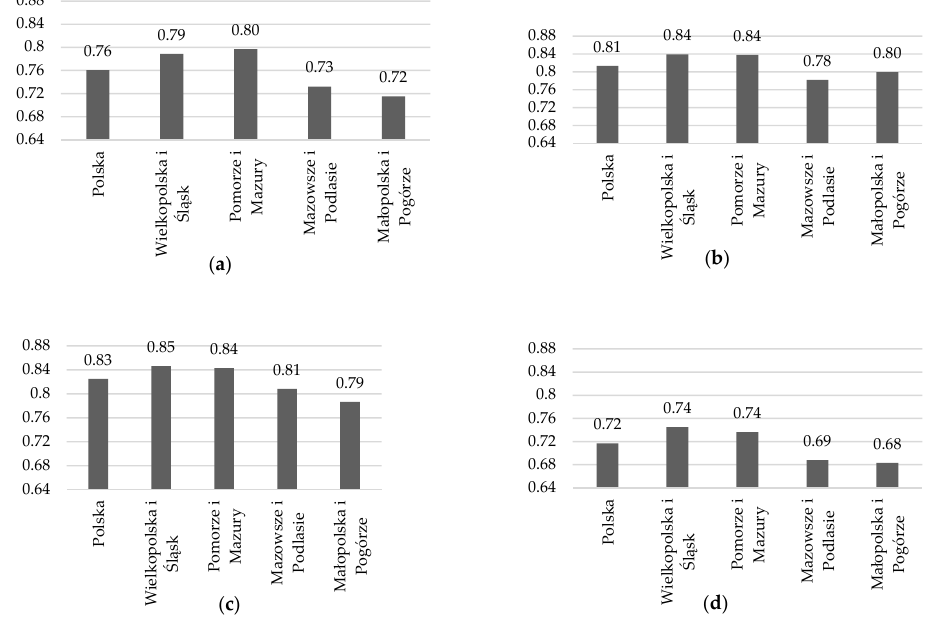
Figure 4. Average technical efficiency of farms in individual regions of Poland depending on the overinvestment group in 2004–2015. ( a ) optimum investment level; ( b ) absolute overinvestment; ( c ) relative overinvestment; ( d ) underinvestment. Source: own elaboration based on EU-FADN–DG AGRI.